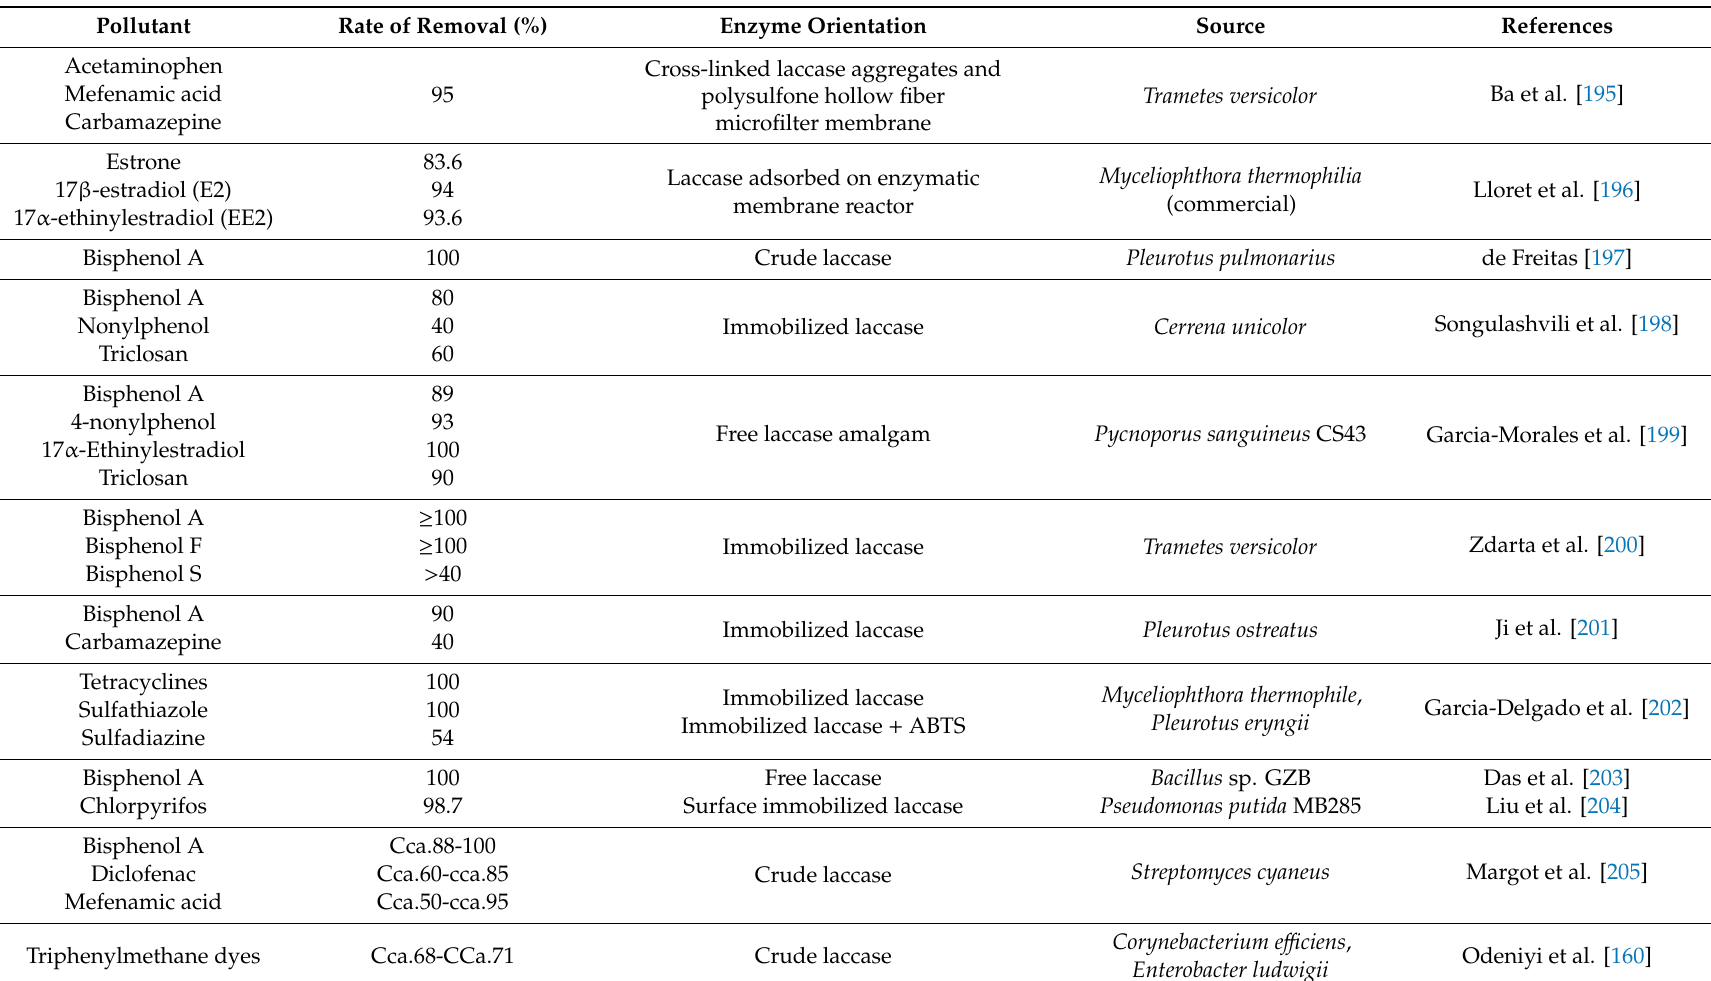
Table 2. The treatment of di ff erent wastewater pollutants in aqueous systems by some